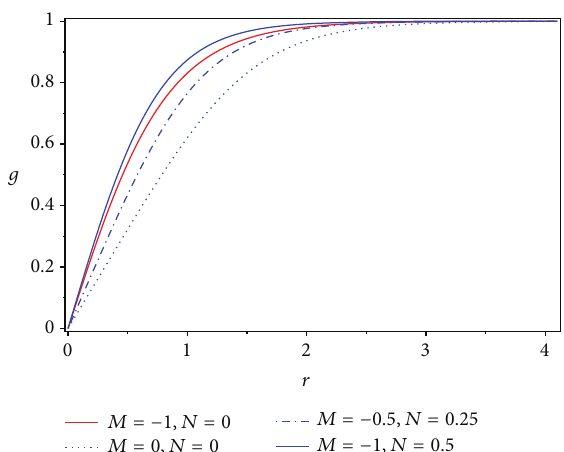
Figure 1: The profiles of the Higgs field 𝑔(𝑟) for 𝑛 = 1 . The red lines represent the solutions for a |𝜙| 4 potential and blue lines for |𝜙| 6 potentials.